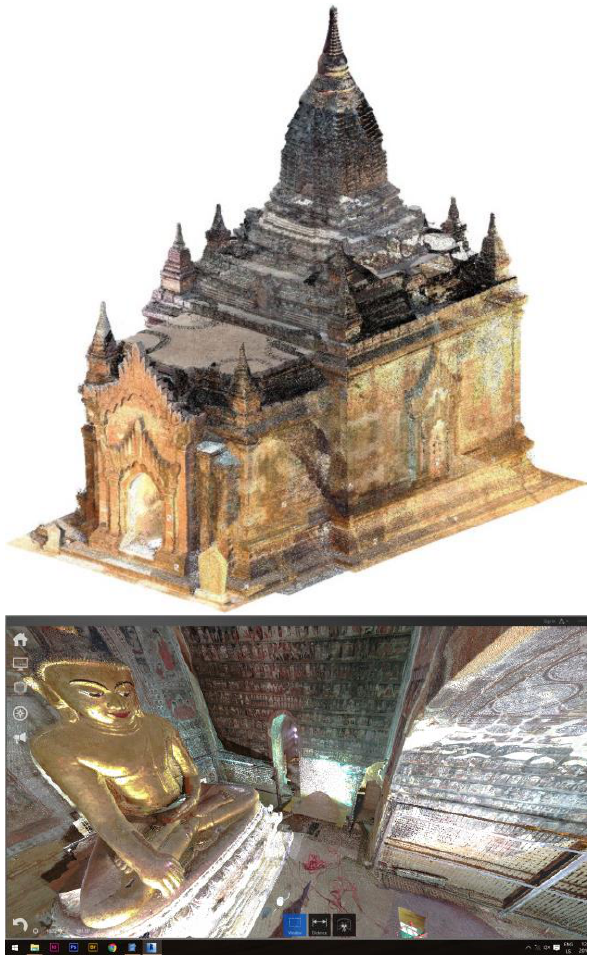
Figure 10 . Pointcloud model of Loka-hteik-pan temple (exterior and interior views). Pointclouds coming from the different techniques (aerial